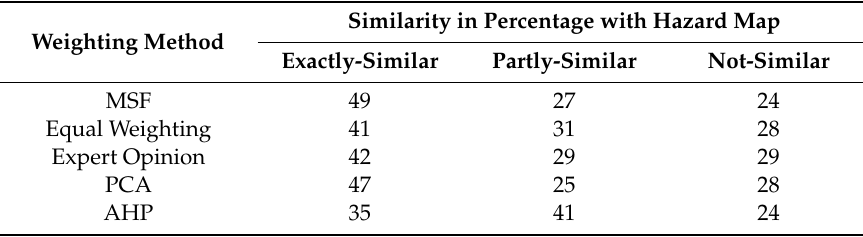
Table 4. Accuracy of MSF compared to other weight